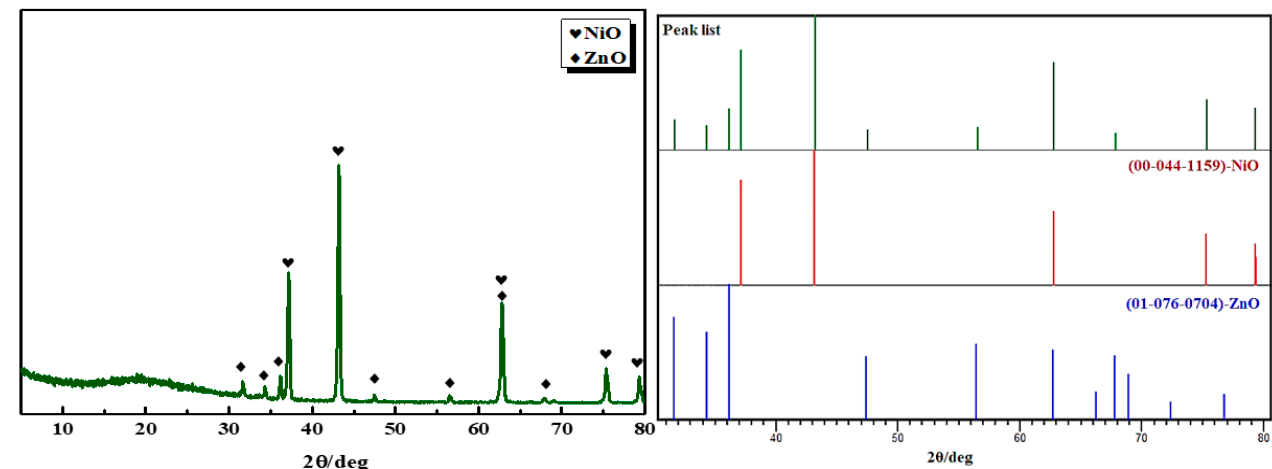
Figure 13. XRD patterns of NiO-ZnO precipitate.